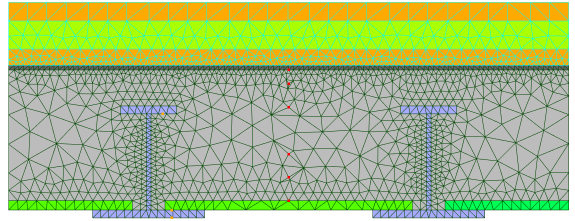
Figure 6. Mesh for bridge deck model under traffic lane with visible layers.